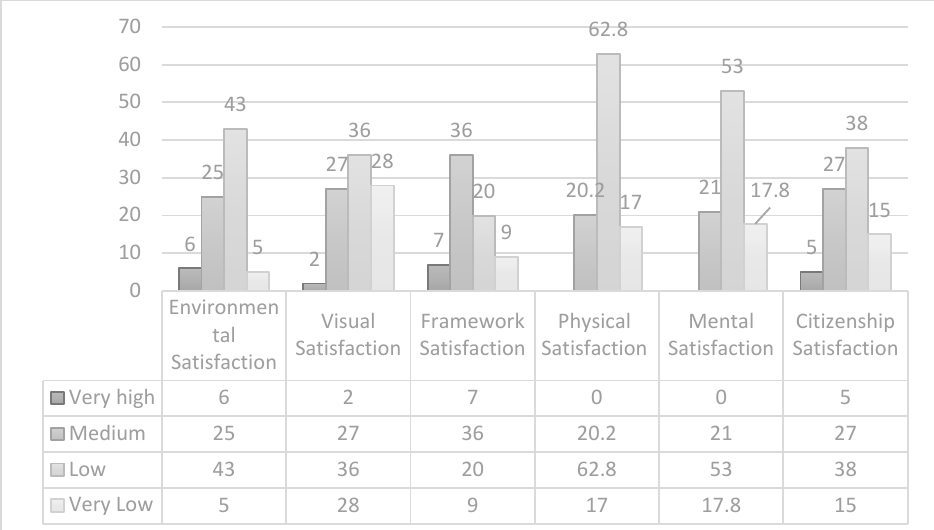
Figure 3. Distribution of research variables from respondents’ point of view.